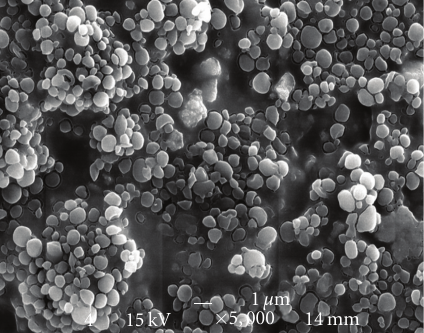
Figure 2: Scanning electron micrograph of the surface of a sample composed of 80 wt% PTFE, 8 wt% N-doped TiO 2 , fluoro-oil and the remainder of fluorine binder. The water repellent property of the sample is attributed to the surface roughness created by the PTFE particles. Figure 3: FT-IR spectrum of PTFE powder. A denotes CF